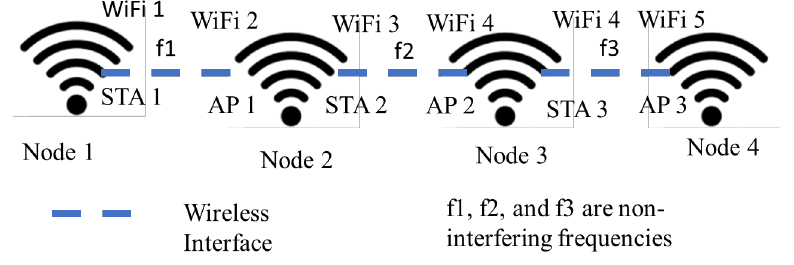
Figure 4. Wireless ad hoc network topology creation at Emulab (W-iLab1.t, W-iLab2.t, and POWDER).